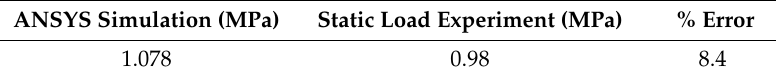
Figure 20 . Static test result. Figure 20. Static test result. Table 6. Static stress validation Table 6. Static stress validation measurement.